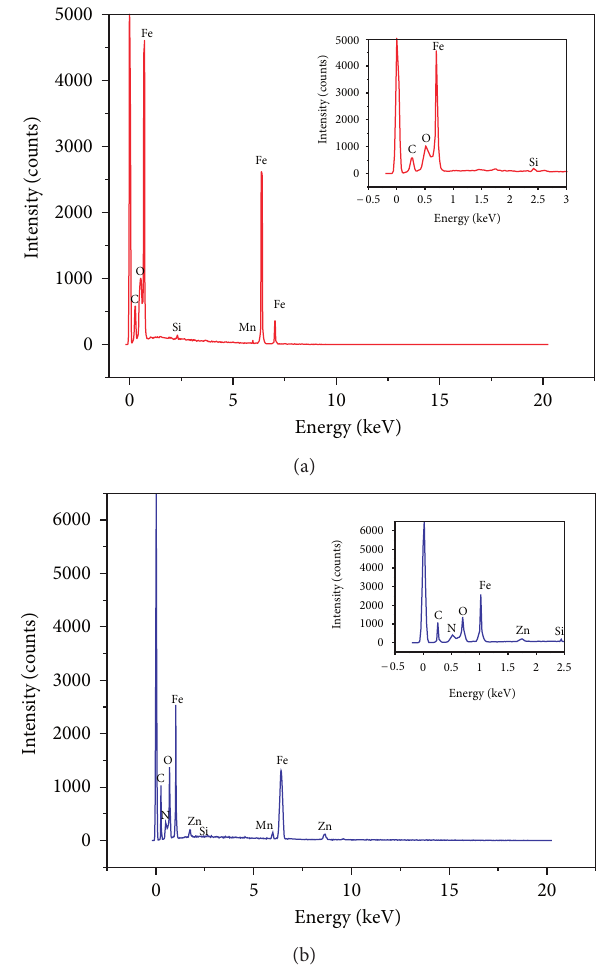
F 6: EDAX spectra of (a) carbon steel sample aer immersion in well water blank. (b) carbon steel sample aer immersion in solution containing well water + DL-phe (150ppm) + Zn